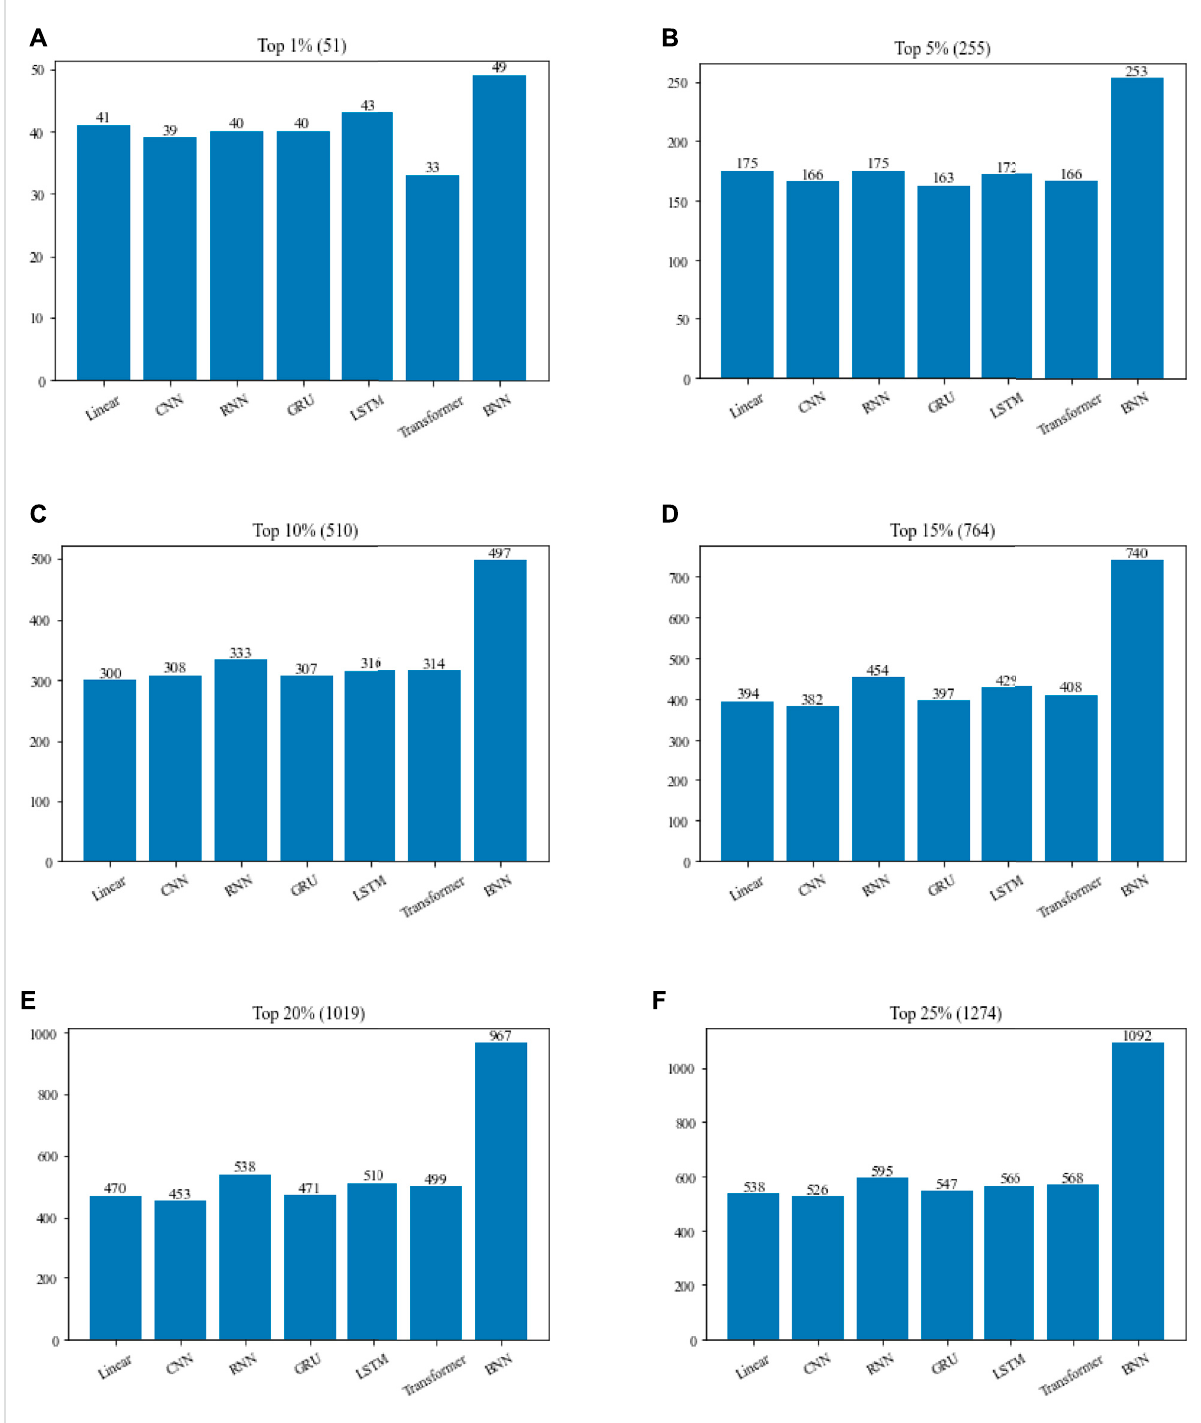
FIGURE 4 PerformancecomparisonofTNNMbyadoptingTNNandsixrepresentativeneuralnetworksbasedontheDIP2010database. (A)